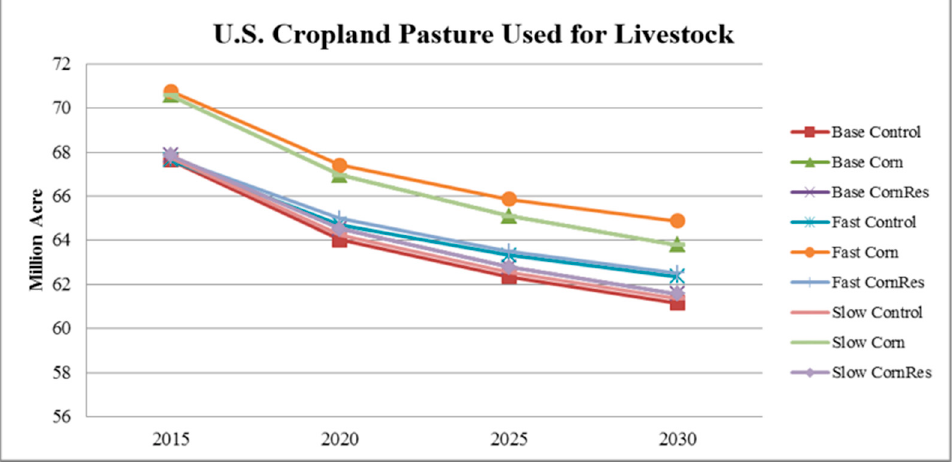
Figure 5. Average U.S. cropland pasture used for livestock projection during 2015 to 2030.